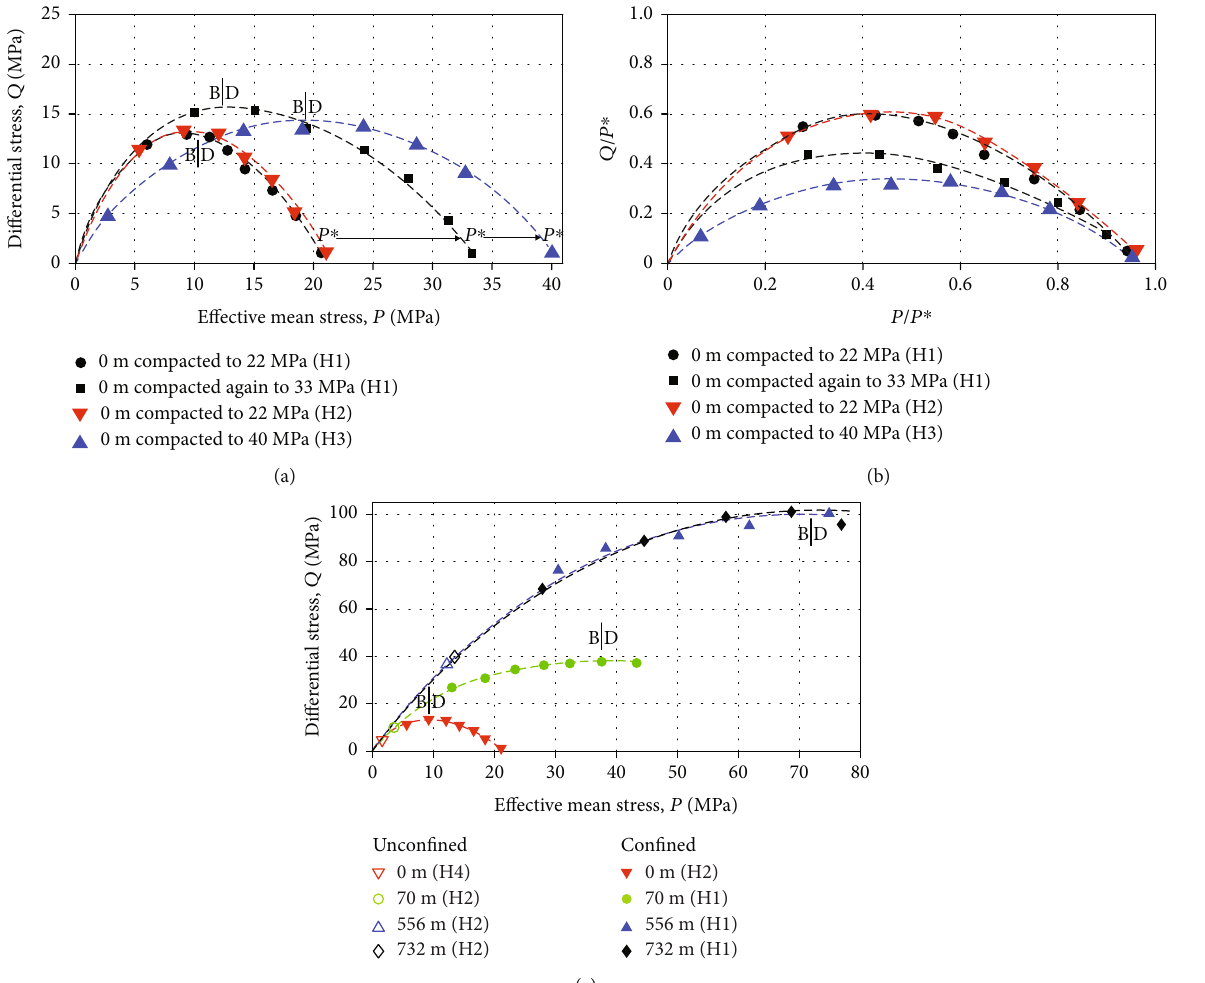
Figure 7: Yield curves of hyaloclastites. (a) Yield curves for the surface hyaloclastite, loaded up to P ∗ (black circles and red triangles) and compacted by loading past P ∗ to 33MPa (using the same sample; black squares) and 40 MPa (blue triangles). The samples compacted beyond P ∗ show elongate yield curves. The transition between brittle and ductile behaviour, termed the critical e ff ective mean stress (critical P ), is approximated for each curve and shown by B|D. (b) The same data normalised by dividing each point by its respective P ∗ value. Peak Q / P ∗ decreases as the samples are compacted beyond P ∗ . (c) Yield curves for subsurface hyaloclastites sampled at di ff erent depths at Kra fl a. The yield curves increase in size with decreasing porosity ( ~ increasing depth) as the samples become stronger. The brittle to ductile transition is shown for each curve, except for the sample from 556 m depth, where it was not met within the pressure conditions tested. The dashed lines connecting the measurements are for visual clarity and o ff er no statistical signi fi